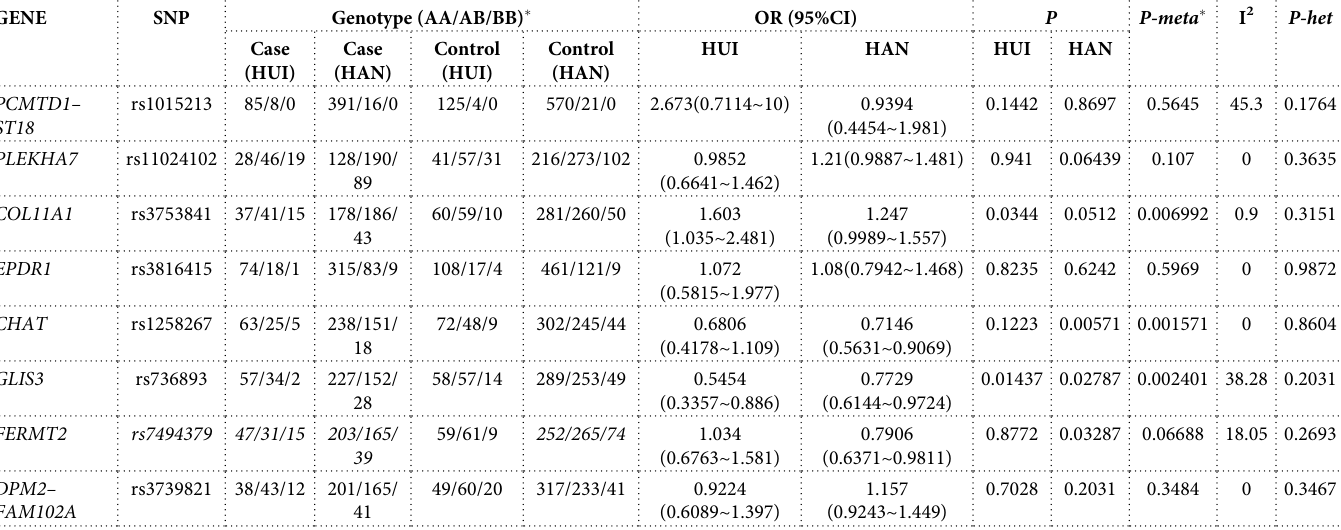
Table 3. Associations of target SNPs between cases and controls in different ethnicities and meta-analysis results.